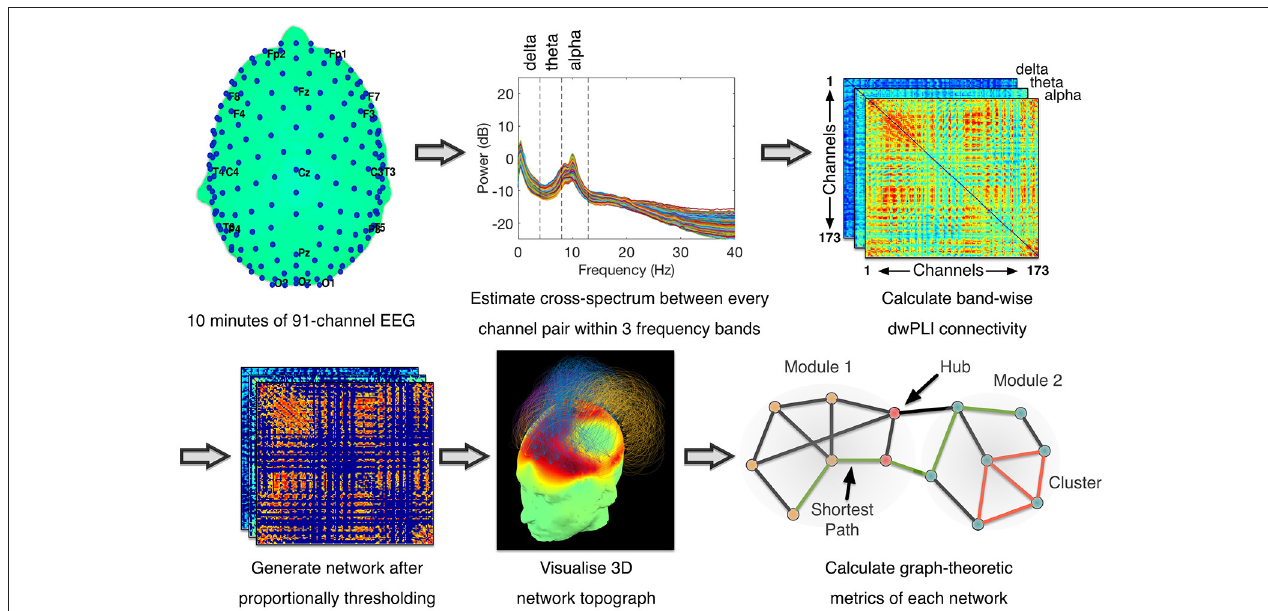
FIGURE 1 | Data Processing Pipeline for Connectivity Analysis - Methodology was identical to (18). Cross-spectral density between pairs of channels was estimated using dwPLI. Resulting connectivity matrices were proportionally thresholded. Thresholded connectivity matrices were visualized as topographs, which combined information about the topography of connectivity with the modular topology of the network (see Figure 2 legend for details). Graph-theoretic metrics were then calculated after binarising the thresholded connectivity matrices.